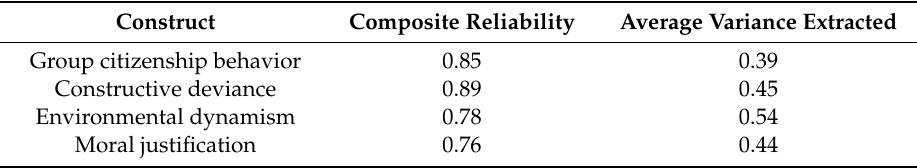
Table 2. The composite reliability and average variance